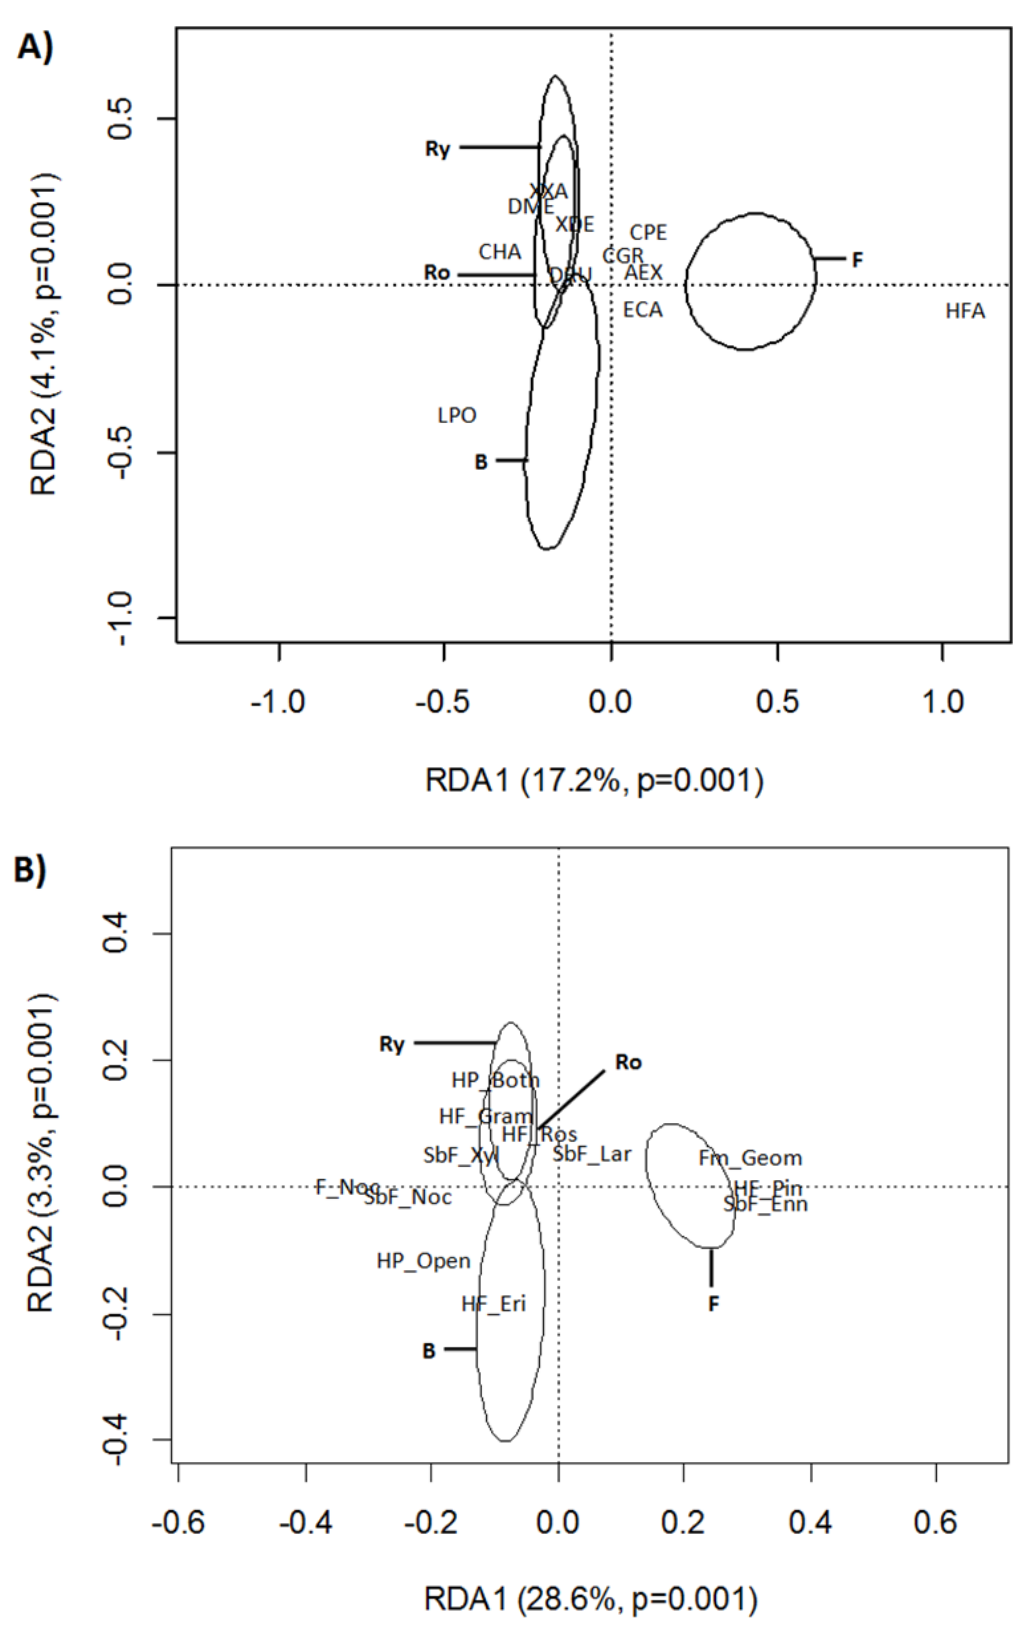
Figure 2. A) Redundancy Analysis (RDA) diagram for moth communities. B) RDA diagram for moth Community Weighted Means (CWMs). Treatments: F = forestry; B = bog; Ro = older restoration; Ry = younger restoration. Functional traits and species code names are shown in Tables A1 and